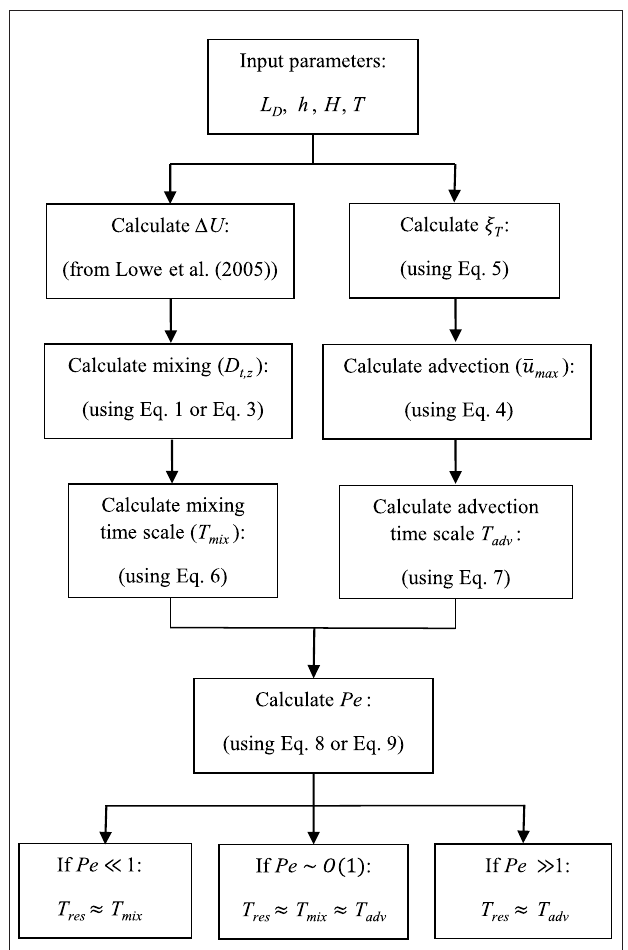
FIGURE 4 | Flowchart representing the framework developed here for estimating residence time in coastal canopies. The input values include wave ( h , H , and T ) and canopy ( L D ) properties. Using the model developed in Lowe et al. (2005) (to calculate 1 U ) and Equations (1) to (8), this framework represents predictive estimation of residence time in submerged canopies under wave-dominated